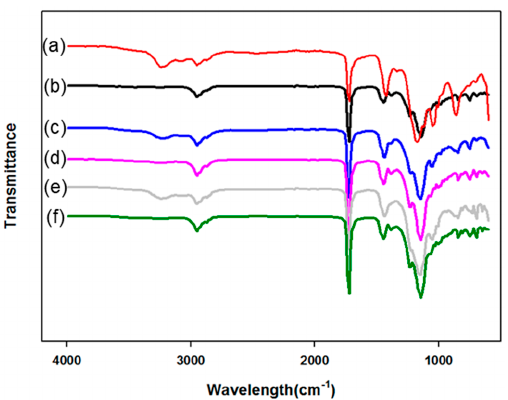
Figure 2. FT-IR spectra of the PMBA/PFSM core/shell nanoparticles by the change of input order and ratio of shell materials: ( a ) TCR-1, ( b ) TCR-2, ( c ) TCR-3, ( d ) TCR-4, ( e ) TCR-5, ( f ) TCR-6.